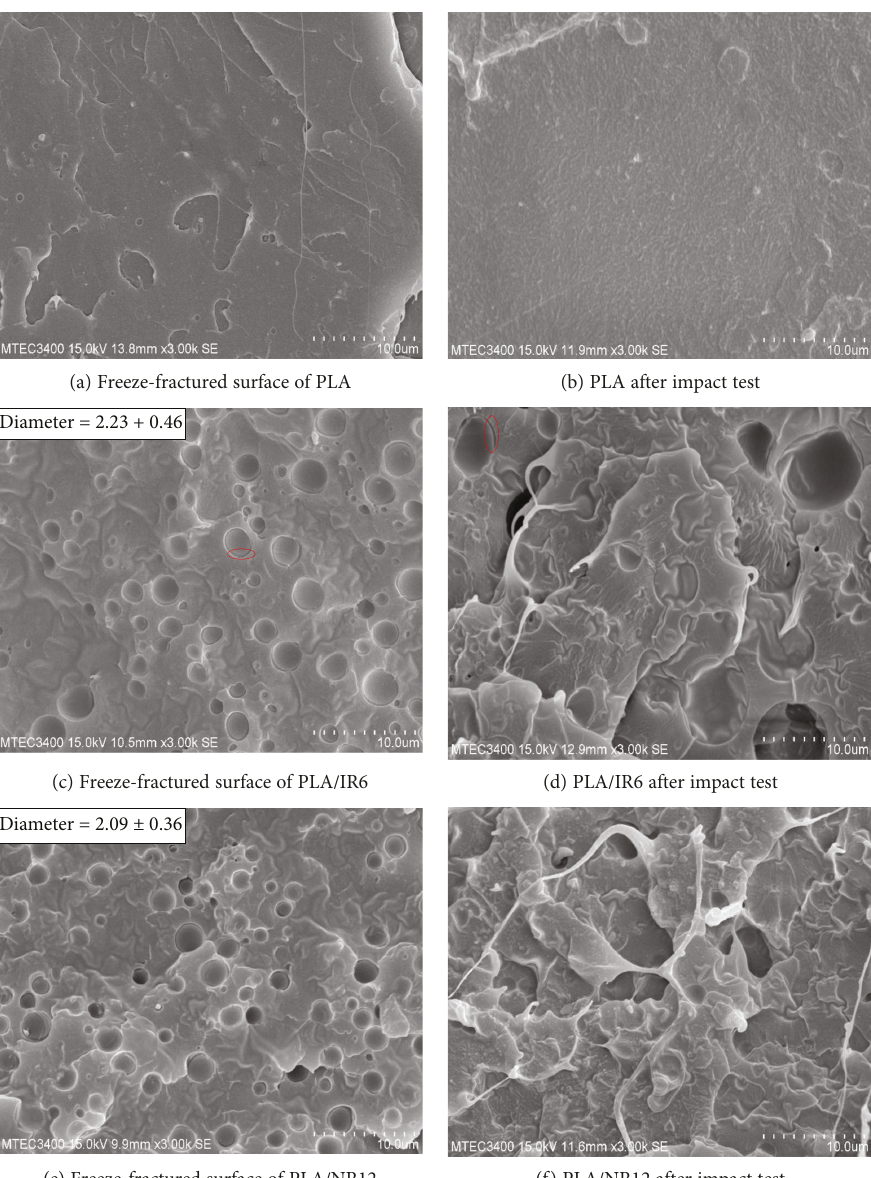
Figure 14: SEM micrographs of the freeze-fractured and impact-fractured surfaces of PLA and the blends of PLA/rubber at